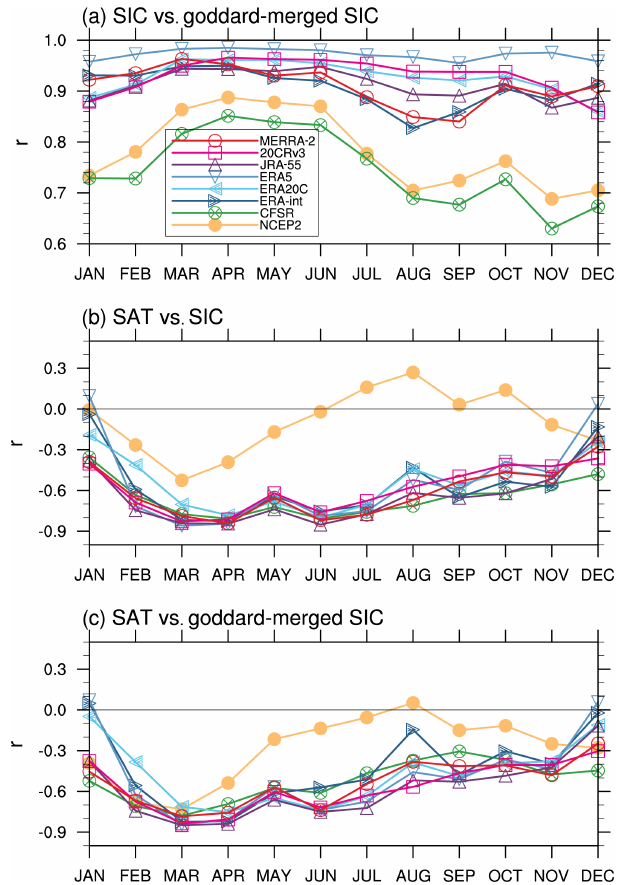
Figure 3. Uncentered pattern correlations by month between 1980– 2010 SIC and SAT trends: (a) correlations between the observed SIC trend and each reanalysis’ SIC; (b) correlations between each reanalysis SAT trend and reanalysis’ SIC trend; (c) correlation be- tween reanalysis SAT trend and observed SIC trend. Differences between each reanalysis SIC and the Goddard merged SIC product for each month are shown in the Supplement Figs.